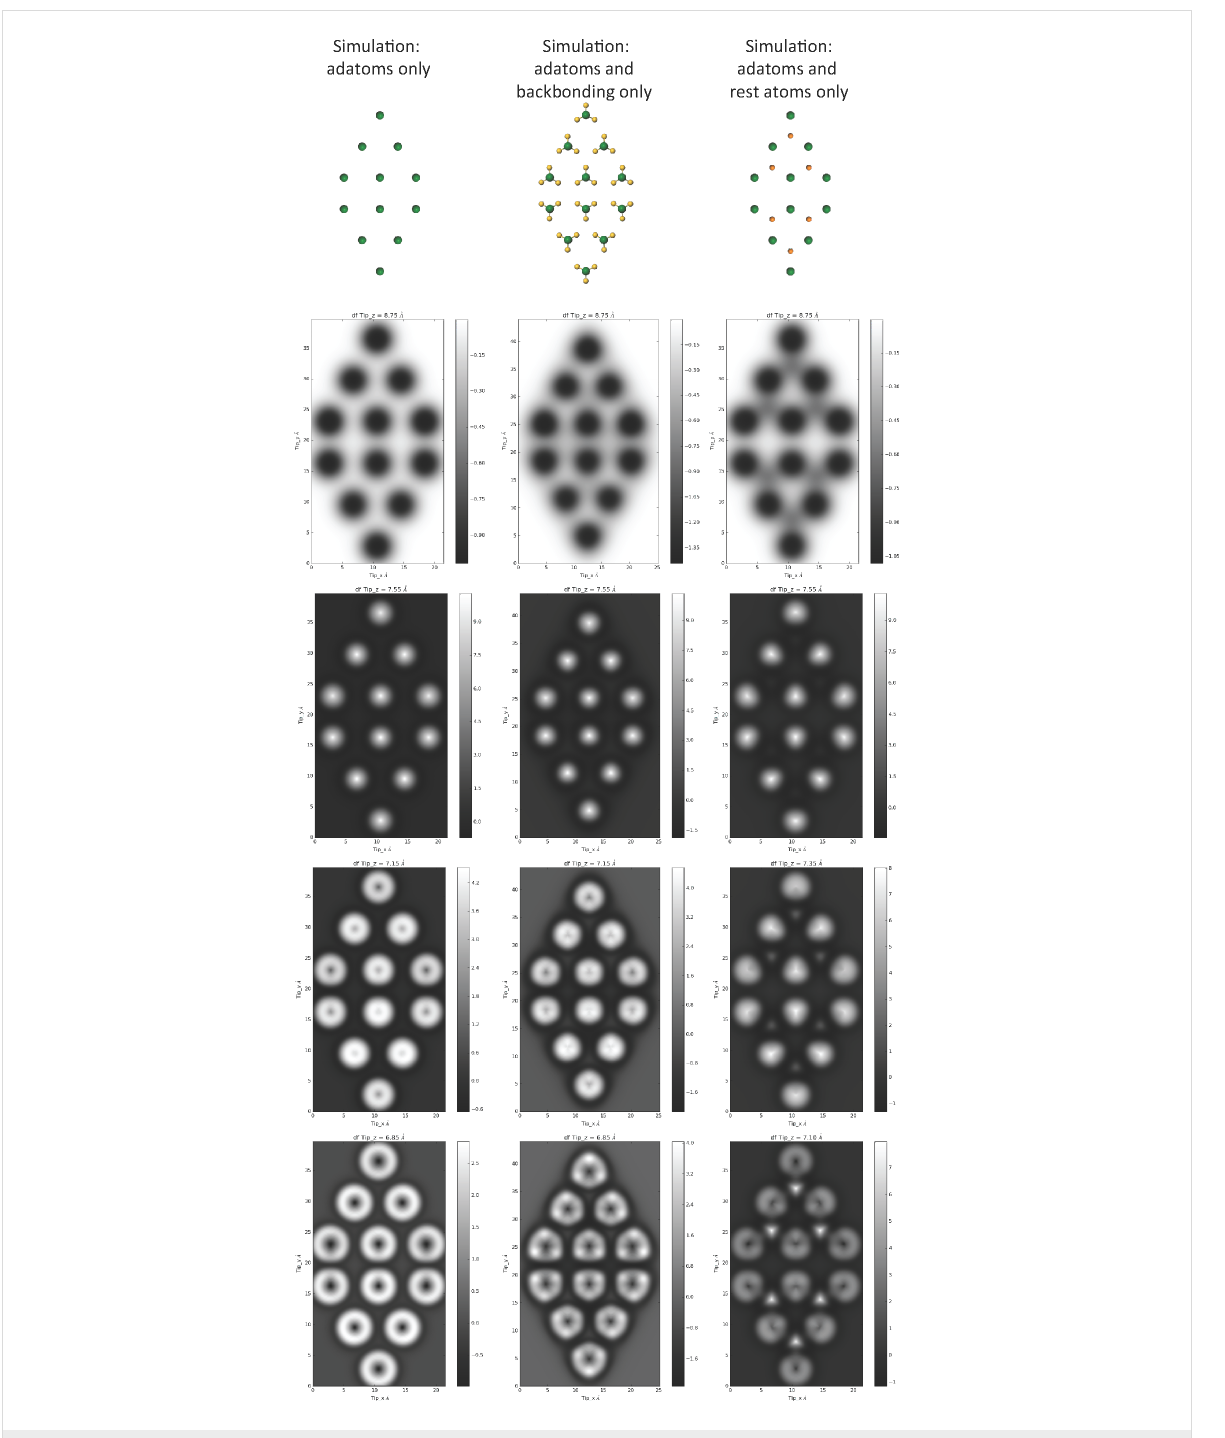
Figure 2: Left column: simulated constant height force images at decreasing tip–sample separation, over a Si(111)-7×7 unit cell containing only the upper adatoms. All atoms image as uniform spheres, at close approach an inversion occurs in the centre of the atoms. Middle column: simulated con- stant height force images at decreasing tip–sample separation, over a Si(111)-7×7 unit cell containing only the adatoms and their backbonding atoms. At close approach the adatoms appear as triangles with a orientation matching the backbonding atoms, with an inversion in the centre of the atoms. Right column: simulated constant height force images at decreasing tip–sample separation, over a Si(111)-7×7 unit cell containing the adatoms and rest atoms (no backbonding atoms). The rest atoms image as triangles as a result of being positioned in the asymmetric potential of the surrounding adatoms. Also note the weak triangular shape of the adatoms as a result of the potential arising from the position of the rest atoms, in addition to the inversion in the centre of the atom. Simulated tip heights, left and middle column: (top to bottom) 0.875 nm, 0.755 nm, 0.715 nm, 0.685 nm, right column (top to bottom): 0.875 nm, 0.755 nm, 0.735 nm, 0.710 nm. Tip stiffness k xy = 0.5 N/m for all